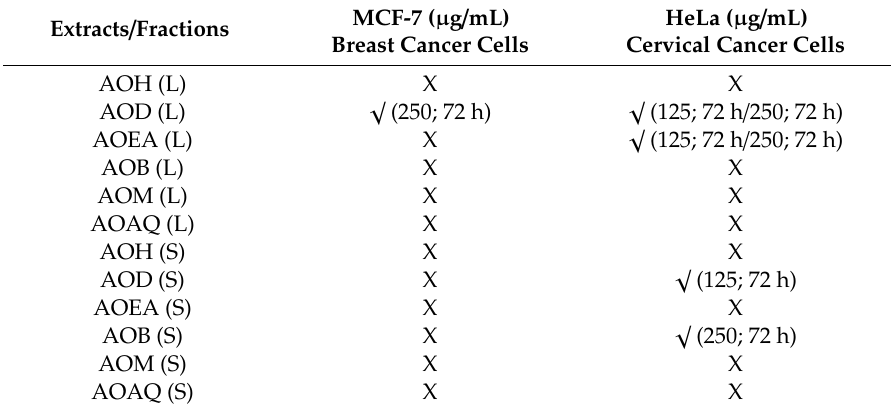
Table 1. First screening of A. orientalis leaf (L) and stem (S) extracts / fractions for their antiproliferative e ff ects on cancer cells using the MTT assay. Extracts /